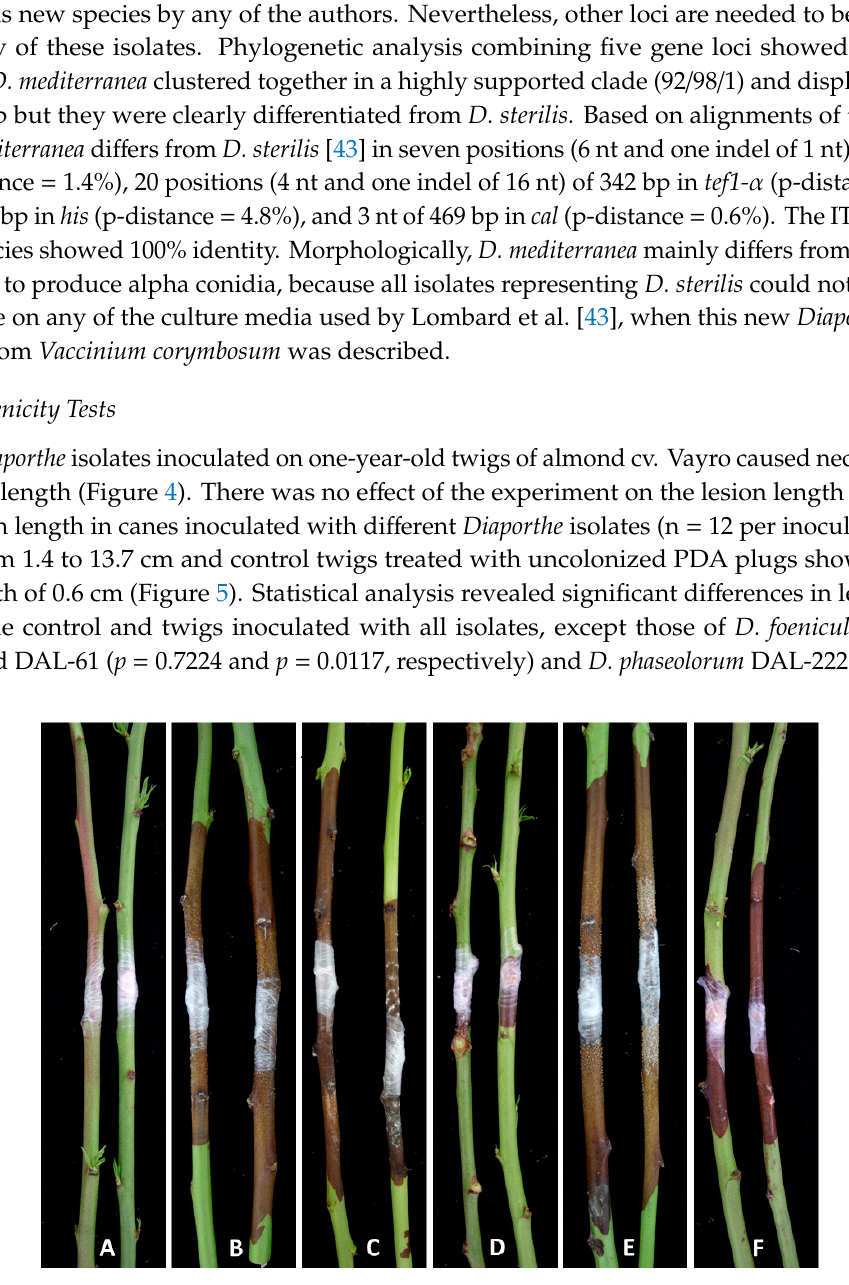
Figure 4. Necrotic lesions induced by the Diaporthe spp. inoculated on almond detached canes. ( A ) Uninoculated control; ( B ) D. amygdali (DAL-4); ( C ) D. eres (DAL-102); ( D ) D. foeniculina (DAL-61); ( E ) D. mediterranea (DAL-34) and ( F ) D. phaseolorum (DAL-222).